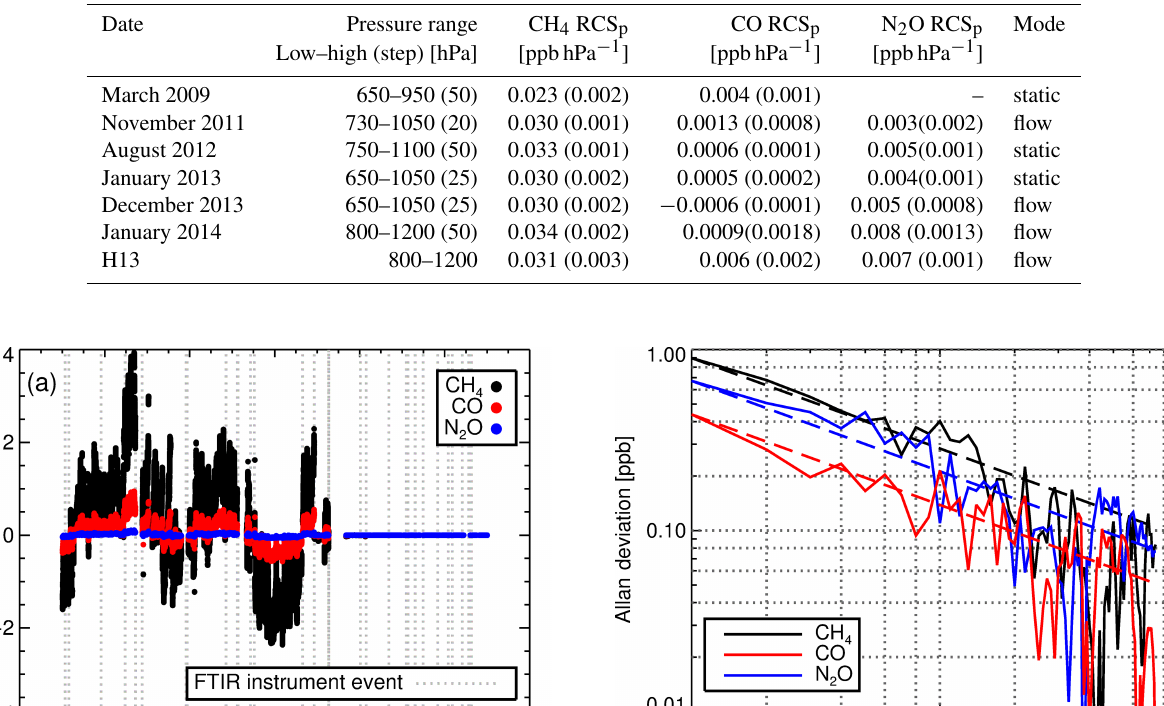
Table 1. CH 4 , N 2 O and CO RCS p including values from H13 (1 σ uncertainty in brackets). The dates of the experiments are given in the first column. In the second column are the pressure ranges and steps (bracketed) the experiments were conducted at. The experiment measurement modes are listed in the last column.